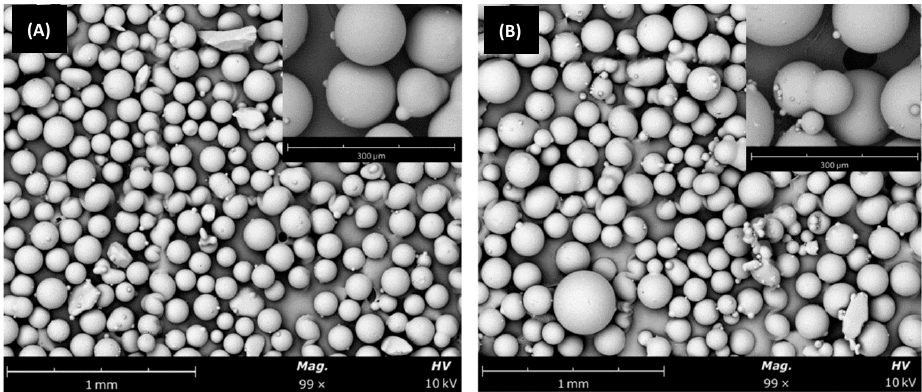
Figure 3. SEM image of the Blasqem glass build powder. ( A ) Fine, and ( B ) rough.